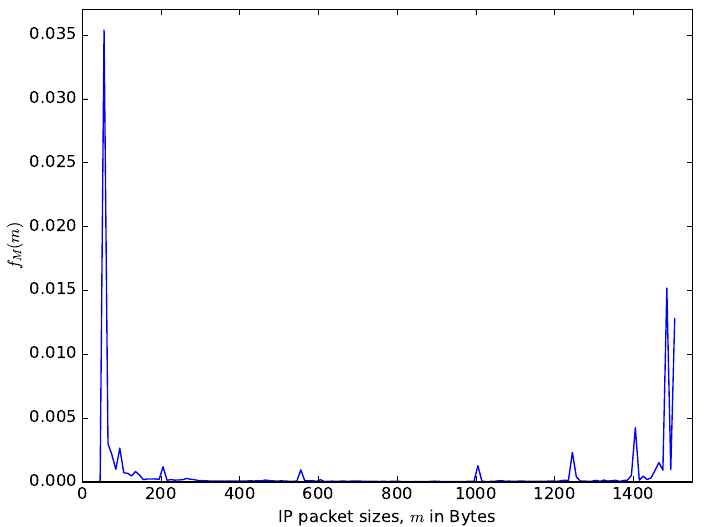
Figure 6. Interarrival time distribution f A ( t a ) , from the CAIDA measurement of the Equinix Chicago link compared with the exponantial distribution with the same mean.